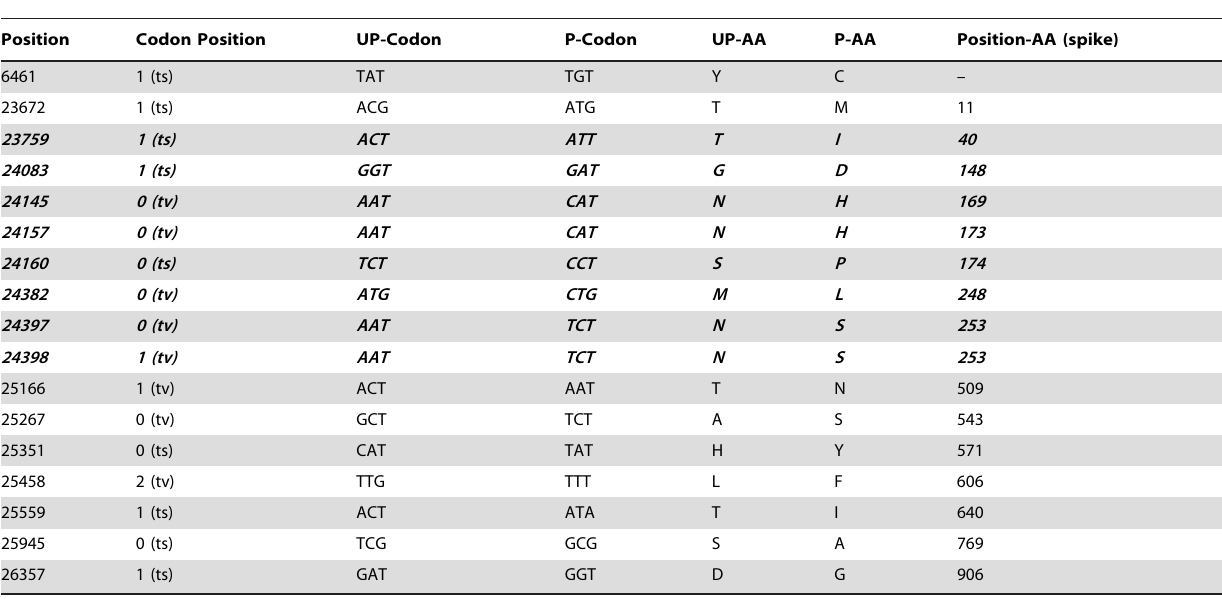
Table 2. Non-synonymous mutations associated with cell